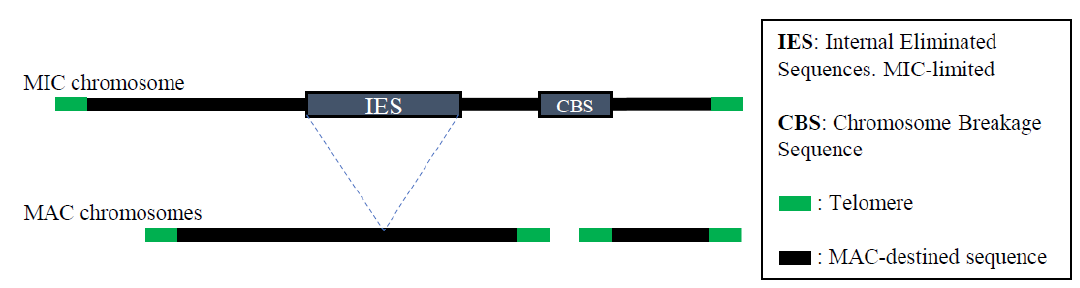
Figure 2. Extensive Programmed DNA Rearrangements in Tetrahymena. These events occur during MAC development where ~10–15% of MIC genome is deleted. See text for additional details.